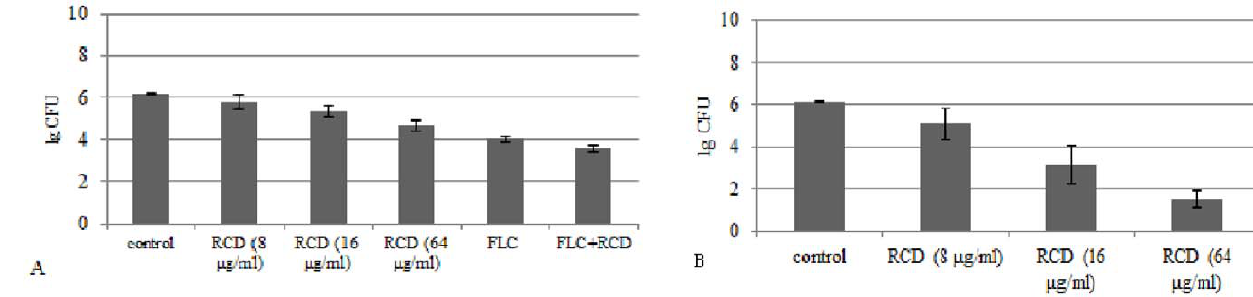
Figure 3. Antifungal effect of riccardin D against C.albicans biofilms formed invivo . ( A ) Riccardin D at different concentrations (8 m g/ml, 16 m g/ml and 64 m g/ml), fluconazole (4 m g/ml), or riccardin D (16 m g/ml) combined with fluconazole (4 m g/ml) was administered once to 4-hour-old biofilms and were allowed to dwell in the catheter for 8 h. Animals in control group received heparinized saline instead of drug solution. After 24 h growth of biofilms, the specimens were removed for quantification. ( B ) Riccardin D at different concentrations (8 m g/ml, 16 m g/ml and 64 m g/ml) were administered to the 24-hour-old biofilms, and allowed to dwell for 8 h per day for 5 days consecutively. Animals in control group received heparinized saline instead of drug solution. After treatment of RCD for 5 days, the specimens were removed for colony count.